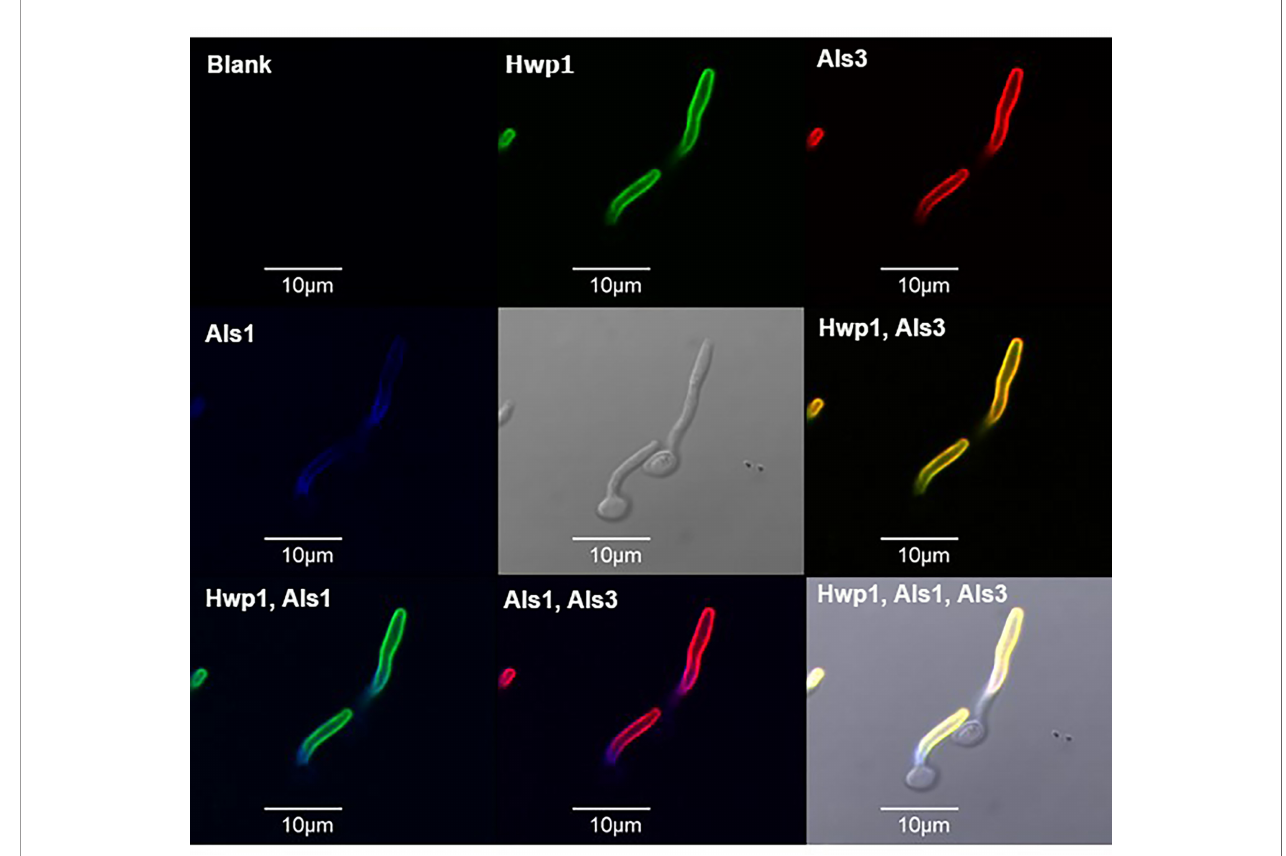
FIGURE 6 | Immunolabeling of C. albicans germ tubes with MAbs speci fi c for Hwp1, Als1, and Als3. C. albicans strain CAI12 was pre-grown as yeast cells in YPD medium, then washed and transferred to RPMI medium for 70 min to form germ tubes. Germ tubes were labeled with anti-Hwp1 2-E8 followed by a secondary FITC antibody (depicted as a green color). Germ tubes were also directly labeled with Alexa Fluor 594-conjugated anti-Als3 (red color) and Alexa Fluor 633-conjugated anti-Als1 (false-colored blue). Pairs of signals were overlaid in other frames and marked accordingly. The yellow color in the “ Hwp1, Als3 ” panel was the combination of individual signals from each protein, indicating shared localization. In contrast, overlaying either Hwp1 or Als3 with Als1 maintained the original colors for each protein, suggesting less overlap between Als1 with either Hwp1 or Als3. The scale bar in each image denotes 10 m